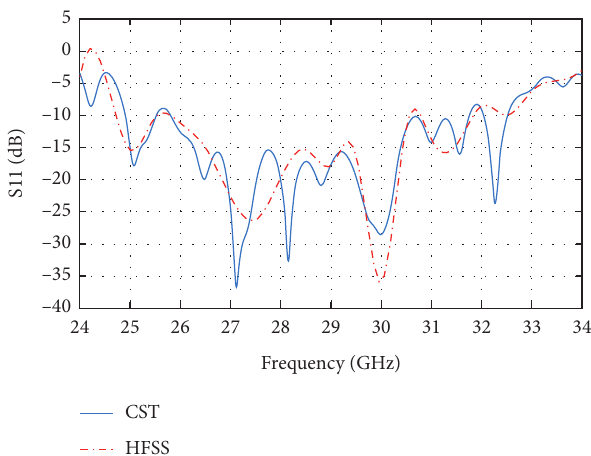
Figure 15: Simulated reflection coefficient of the 16 × 16 CP array antenna.